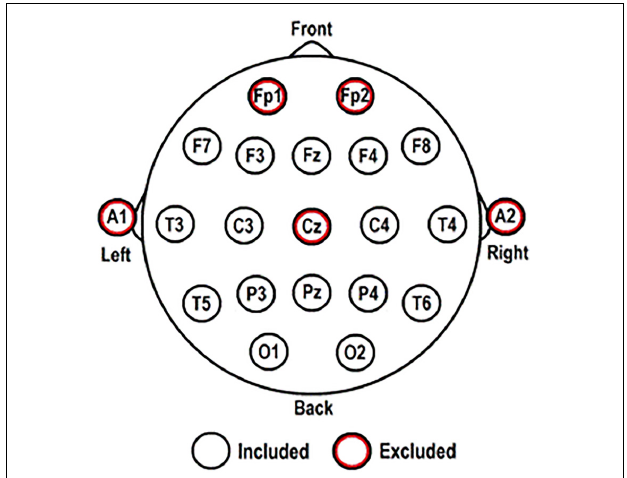
FIGURE 1 | Electrode positions according to the International 10-20 System. The five red-circled electrodes were excluded from all analyses.